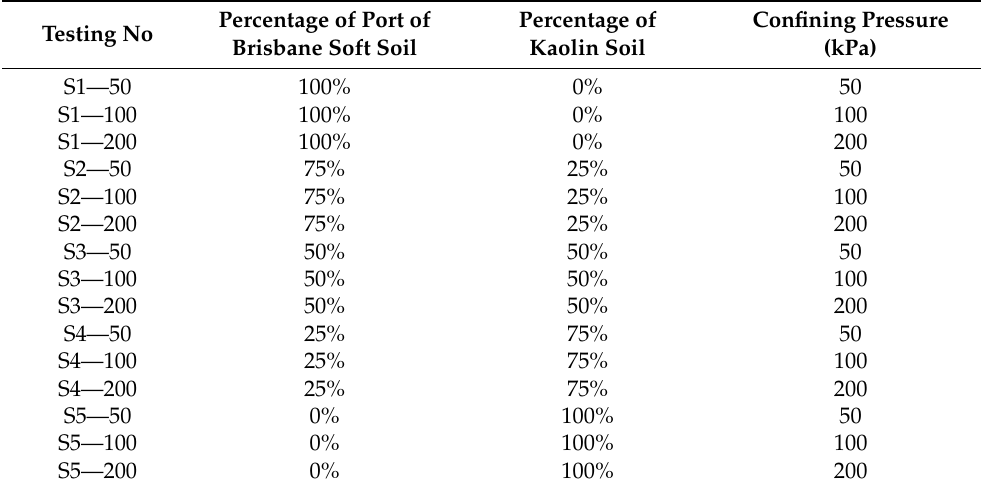
Table 3. Summary of all tested triaxial specimens under consolidated undrained conditions.